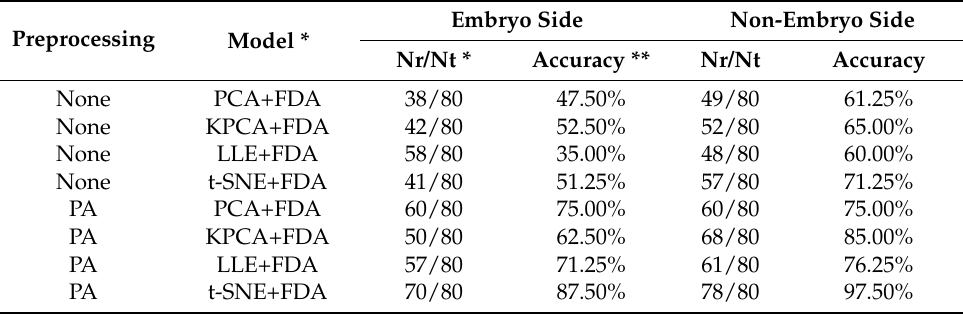
Table 1. Classification results of the test set for eight waxy maize varieties using spectra